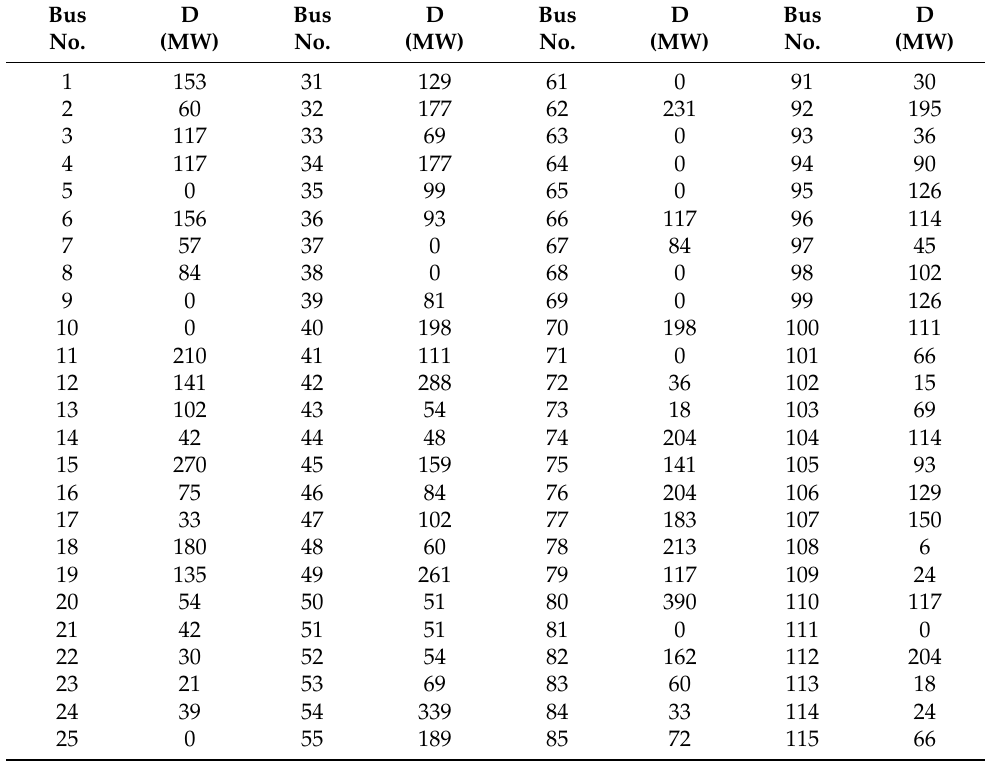
Table A5. Bus data of the modified IEEE 118-bus